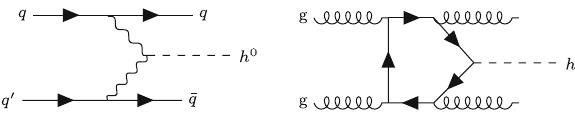
Fig. 3 RepresentativediagramsforproductionofHiggssignalthrough (left) electroweak VBF channel and (right) a higher-order QCD process ingluonfusionwheretwoQCDjetscanbedetectedalongwithasizable missing transverse-energy from invisible Higgs decay